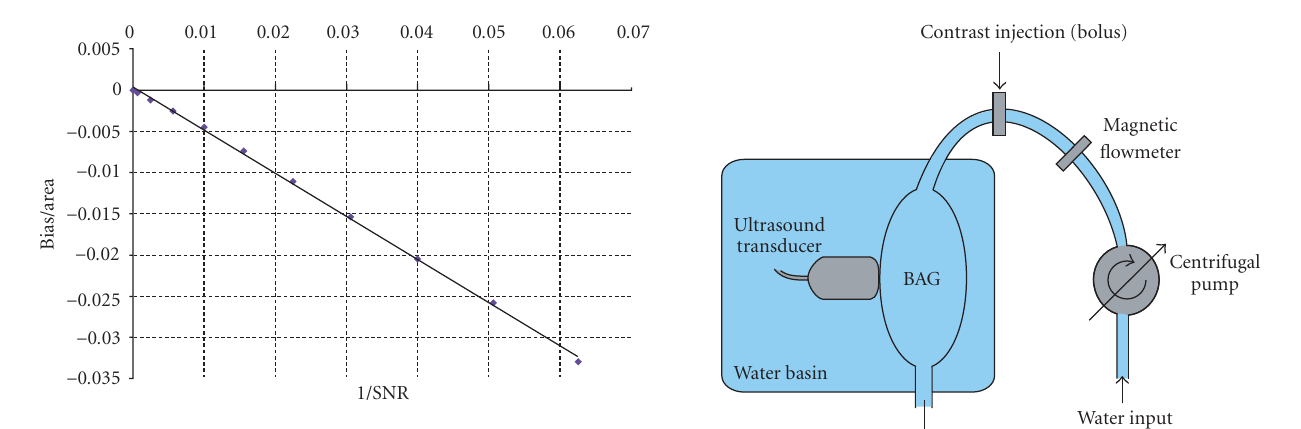
Figure 8: The increase of the negative bias (normalized to the esti- mated area [ m/q ] e ) as function of k .